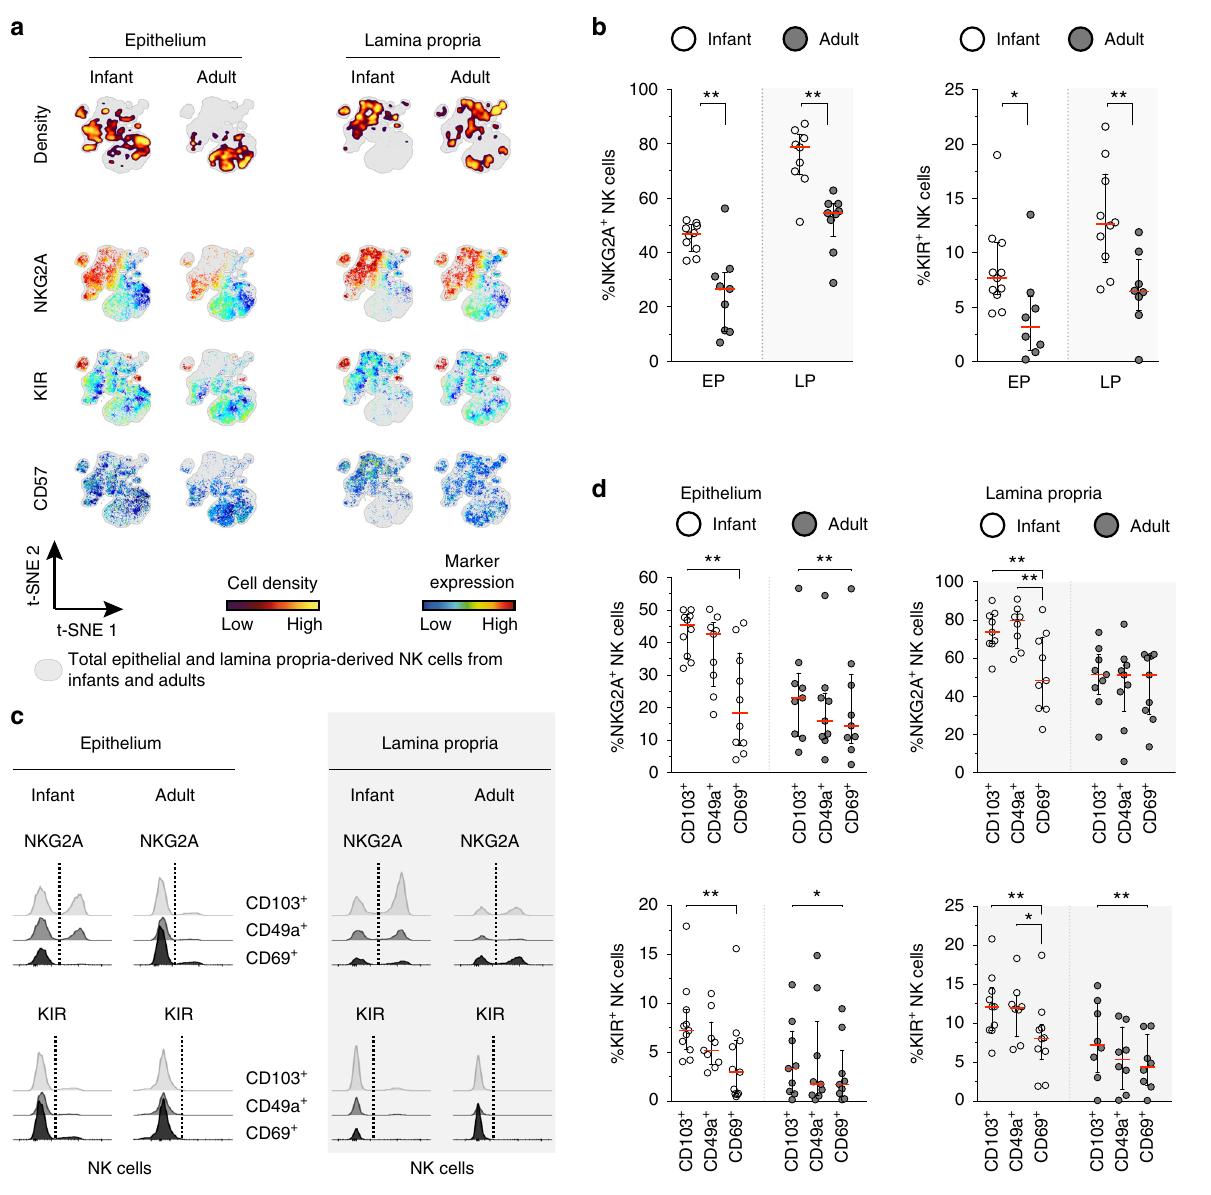
Fig. 4 Infant intestinal NK cells have high NKG2A expression. a viSNE plots of combined fl ow cytometric data visualizing NKG2A, KIR, and CD57 expression by infant and adult epithelial (EP) and lamina propria-derived (LP) NK cells. Cell density of clusters is shown in fi rst row. The expression of NKG2A, KIR, and CD57 is shown by color coding in relative intensity below. viSNE plots are calculated from concatenated FCS fi les gated on NK cells (infant samples N = 9, adult samples N = 6, iterations = 7500 perplexity = 100, KL divergence = 2.29). b Frequencies of epithelial and lamina propria- derived infant (white circles) and adult (dark circles) NKG2A + NK cells and KIR + NK cells (EP infant samples NKG2A ( N = 10), KIR ( N = 11), LP infant samples NKG2A ( N = 9), KIR ( N = 10), EP adult samples NKG2A ( N = 9), KIR ( N = 8), LP adult samples NKG2A ( N = 9), KIR ( N = 8)). c Histogram overlay of fl ow cytometric data showing NKG2A and KIR expression by CD103 + (gray), CD49a + (dark gray), and CD69 + (black) NK cells from infant and adult intestines. d Frequencies of infant (white circles) and adult (dark circles) intestinal NKG2A + NK cells and KIR + NK cells within CD103 + , CD49a + , or CD69 + populations. NKG2A expression by infant EP CD103 + ( N = 10), CD69 + ( N = 10), and CD49a + ( N = 9) NK cells, NKG2A expression by infant LP- derived CD103 + ( N = 9), CD69 + ( N = 9), and CD49a + ( N = 8) NK cells. NKG2A expression by adult EP and LP-derived NK cells ( N = 9). KIR expression by infant EP CD103 + ( N = 11), CD69 + ( N = 11), and CD49a + ( N = 9) NK cells. KIR expression by infant LP-derived CD103 + ( N = 10), CD69 + ( N = 10), and CD49a + ( N = 8) NK cells. KIR expression by adult EP ( N = 9) and LP-derived ( N = 8) NK cells. Median frequencies indicated by red lines. Error bars de fi ne interquartile ranges between 75th and 25th percentiles. Statistical comparisons are Mann-Whitney U comparisons ( b ) and Wilcoxon matched-pairs signed rank tests ( d ). Asterisks represent the following p -values: * p < 0.05 and ** p <